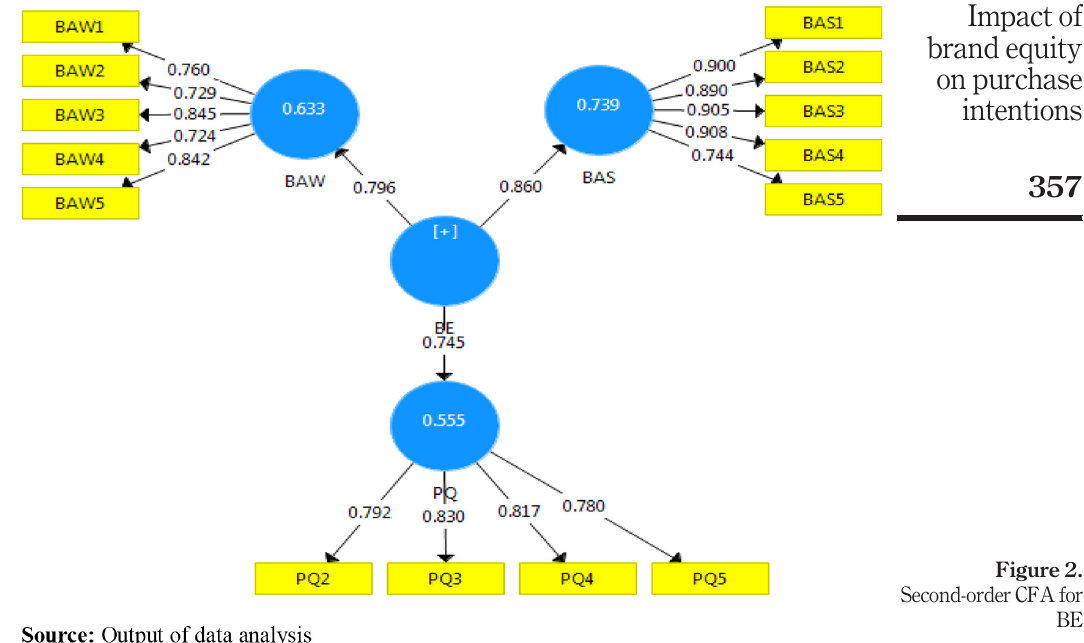
Figure 2. Second-order CFA for